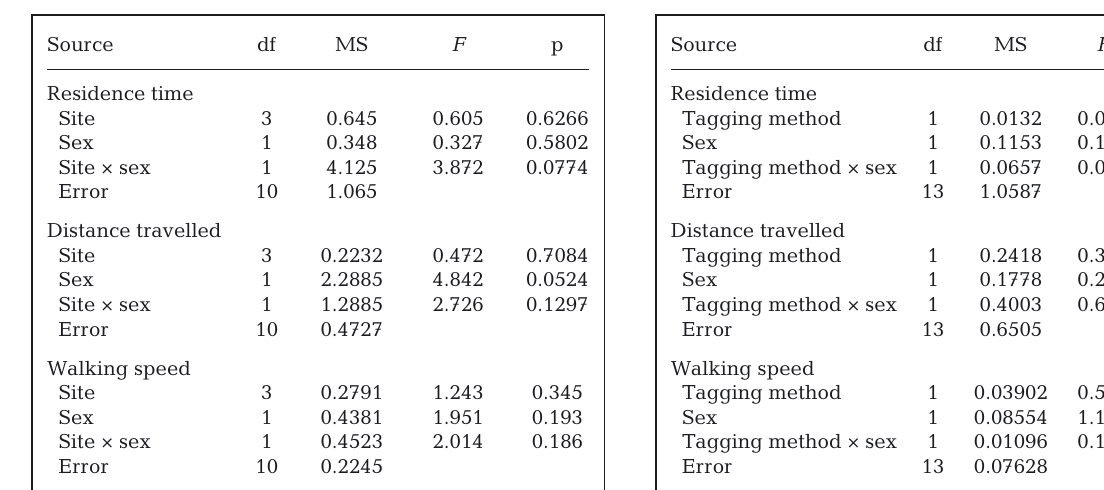
Table 4. Results of 2-way ANOVAs evaluating the effects of ‘tagging method’ and ‘sex’ on residence time, total dis- tance travelled, and average walking speed during post- acclimation in